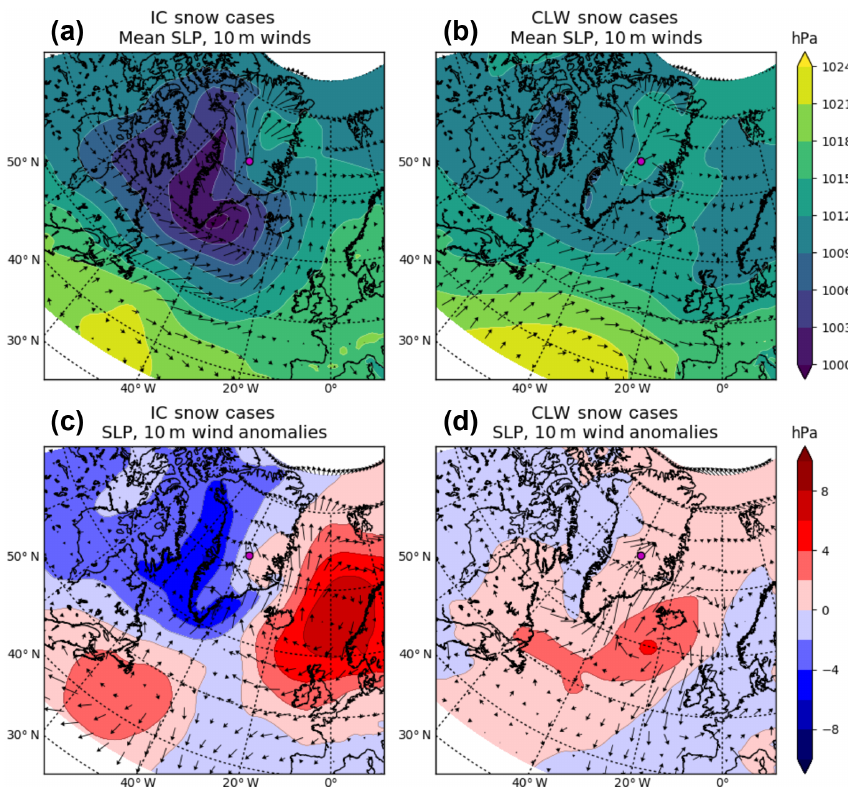
Figure 10. Panel (a) shows the ERA-Interim derived average SLP and 10m winds for 90 IC snow events. Panel (b) shows the same, but for 84 CLW snow events. Both plots are on the same scale. Panels (c, d) show the anomalies for the SLP and 10m winds for the respective cases. The persistent low pressure and strong 10m winds are evident for the IC snow cases. In the cases for the CLW snow, there are relatively calm winds and uniform mean SLPs. Both the cyclone and anti-cyclone structure features in the IC snow cases are quite anomalous, whereas the broad high-pressure field in the CLW cases is weakly